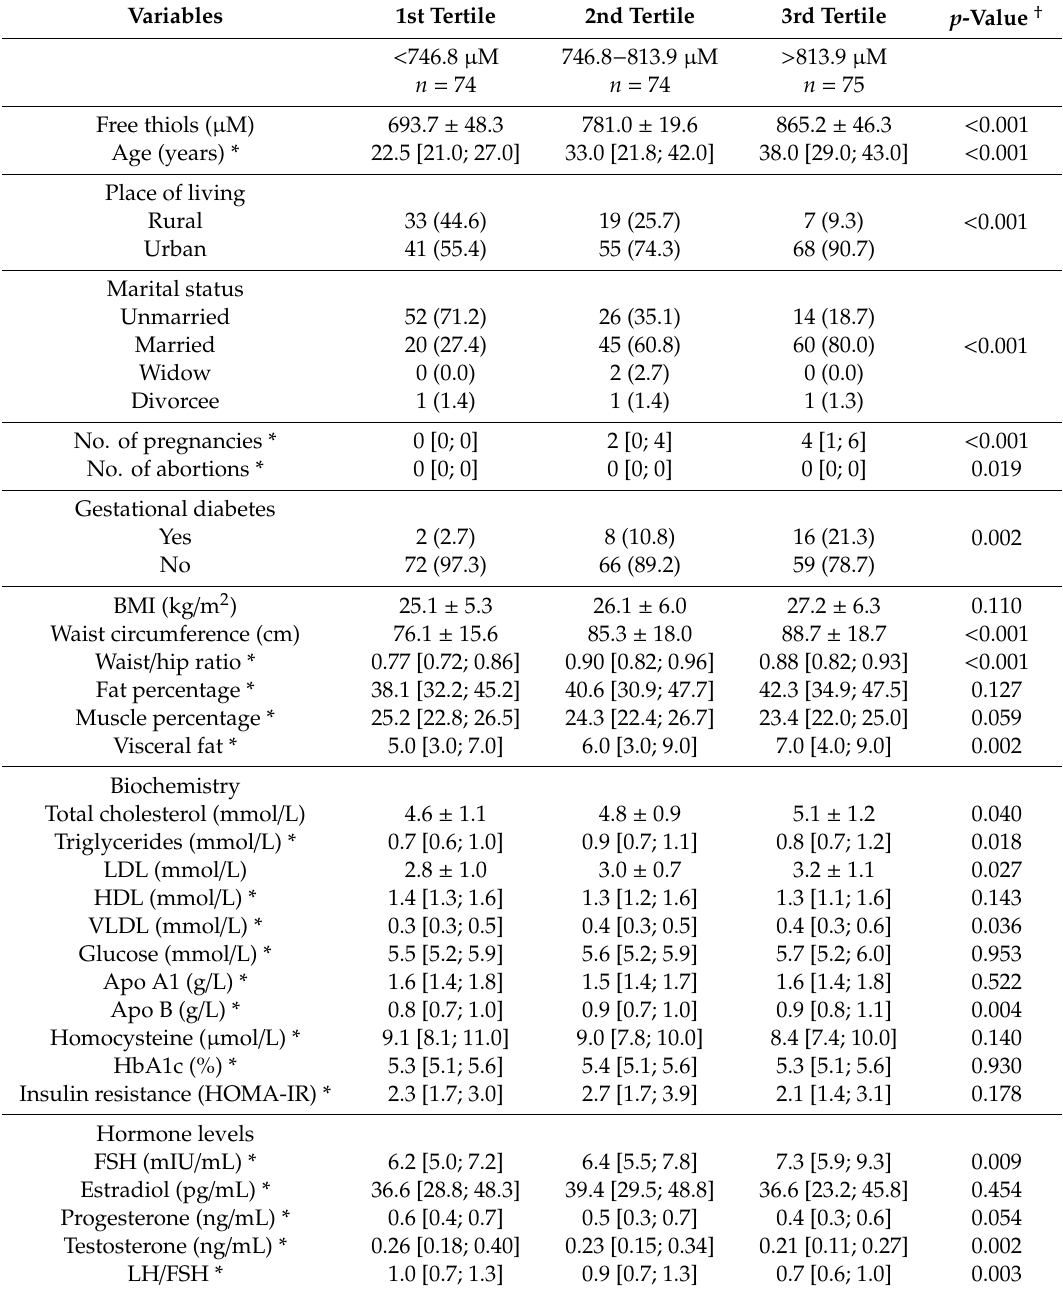
Table 1. Cohort characteristics of reproductive women ( n = 223) with comparison between tertiles of serum free thiol